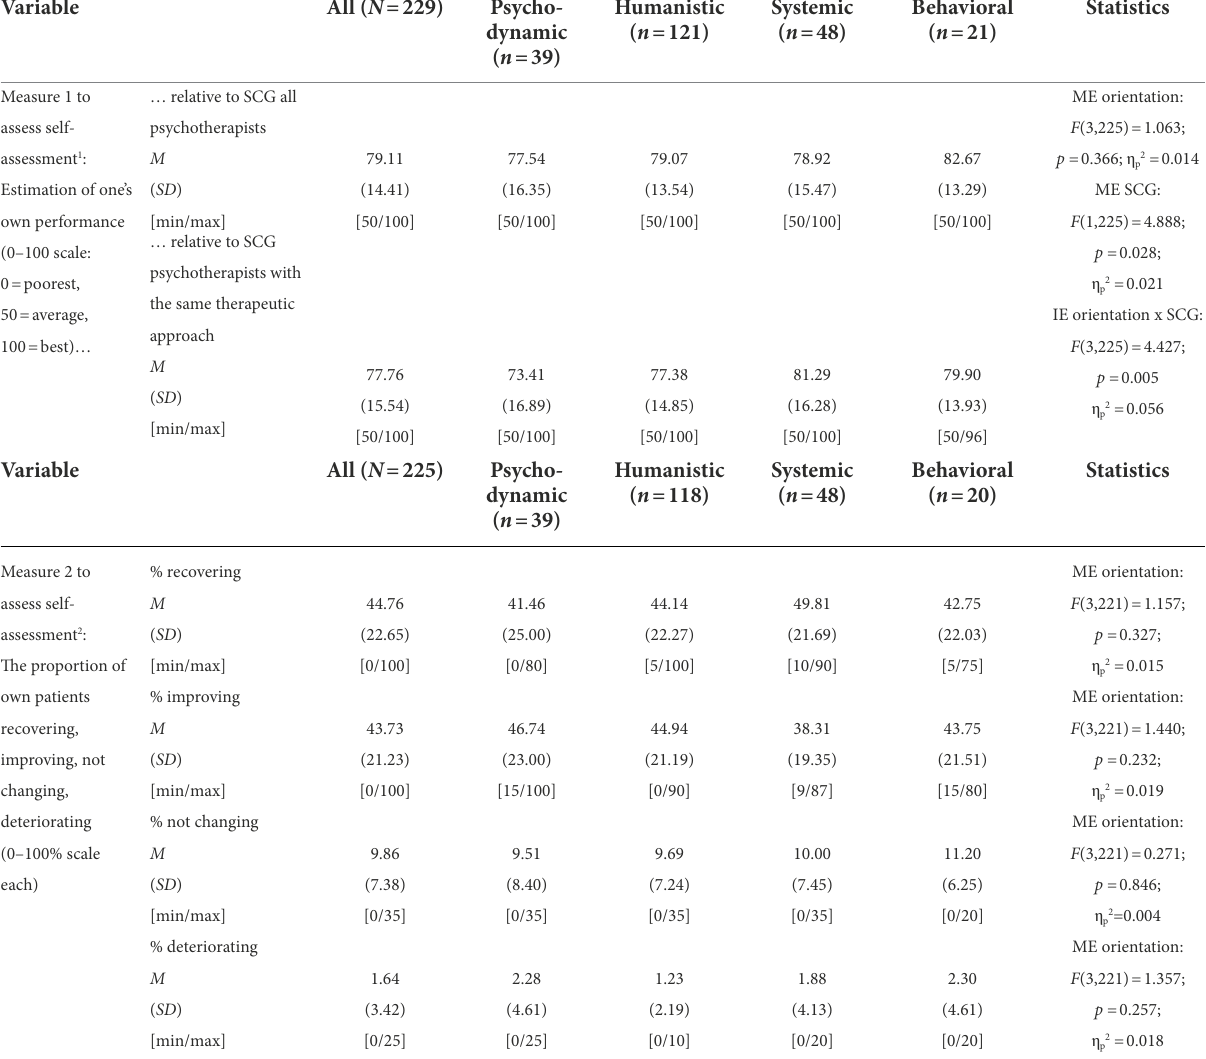
TABLE 2 Results for the two measures of the self-assessment bias.